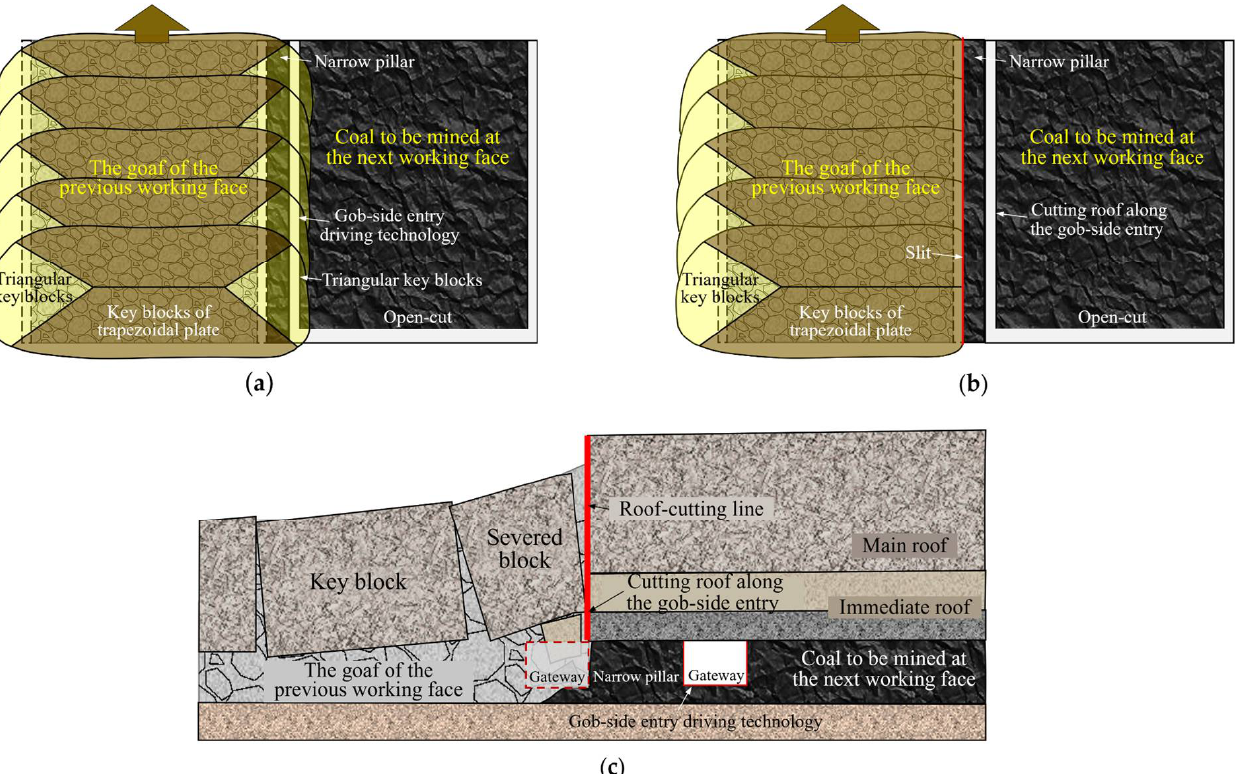
Figure 9. The schematic diagram of roof-cutting for gob-side entry driving. ( a ) Roof structure without roof cutting ( b ) Roof structure after roof cutting ( c ) Cutting roof and unloading the pressure along the gob-side entry.